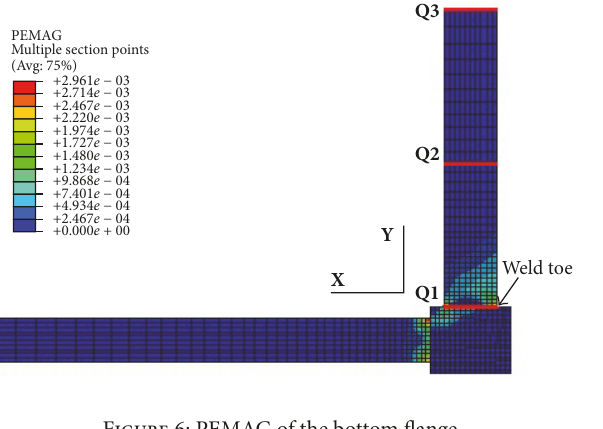
Figure 6: PEMAG of the bottom flange.